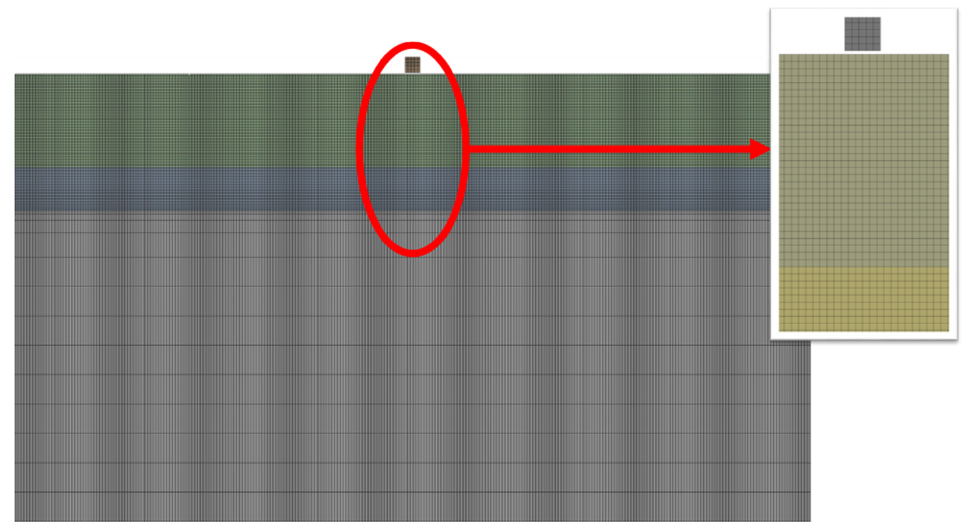
Figure 3. Mesh used in the finite element simulation.